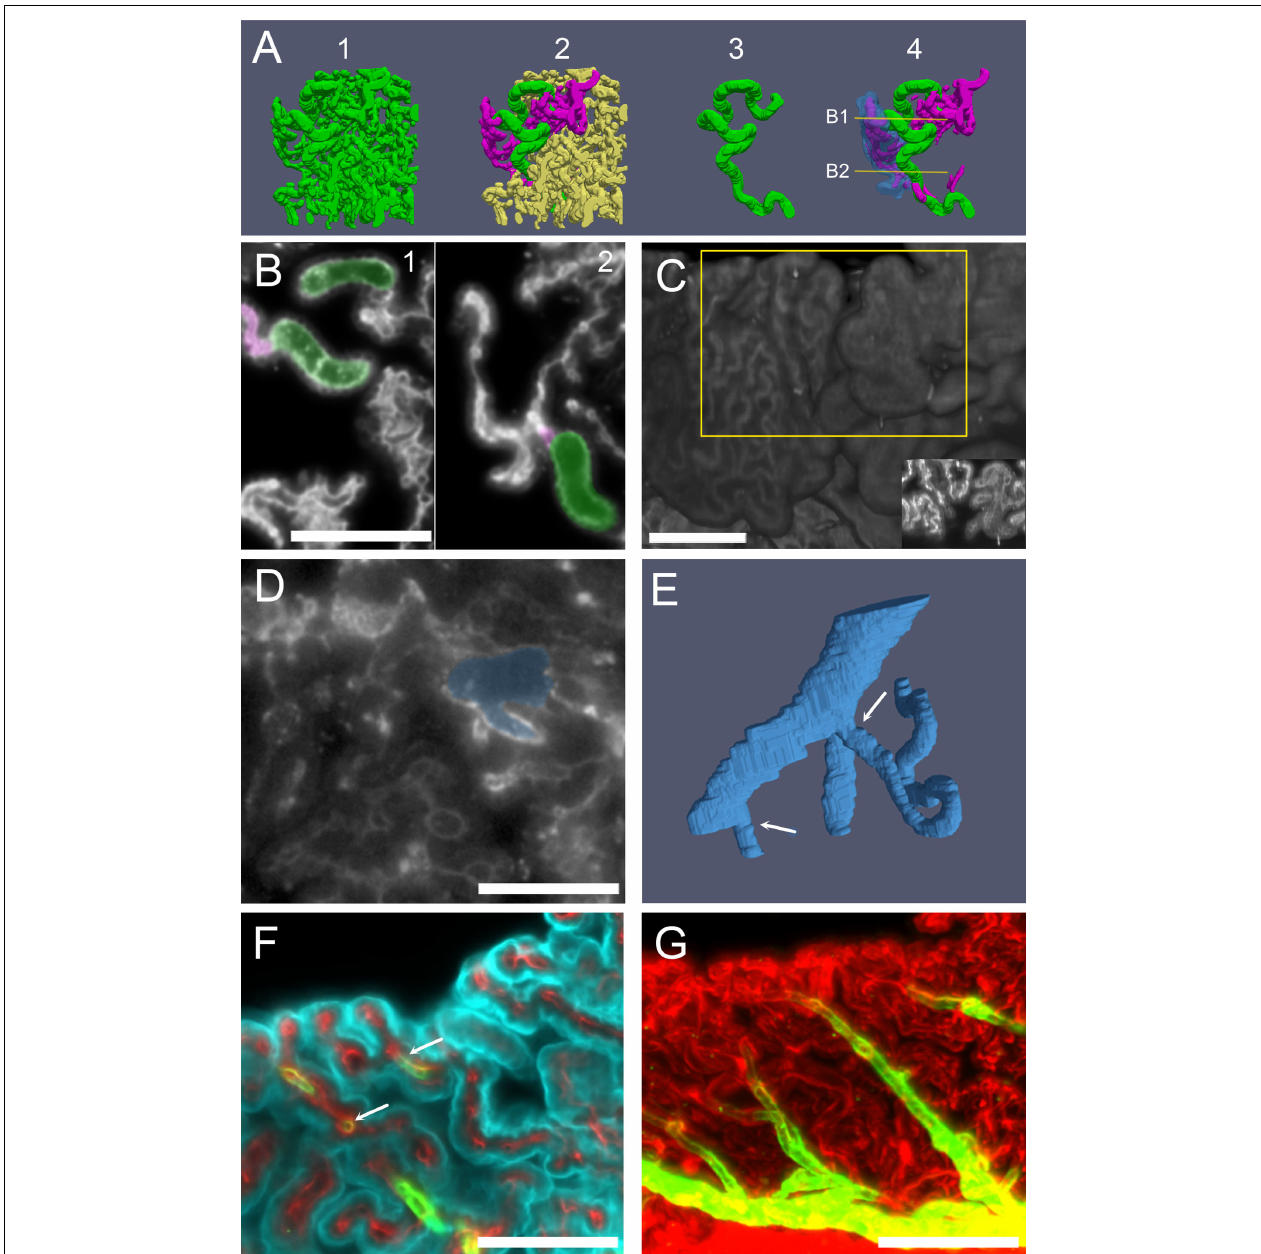
FIGURE 8 | Capillaries. (A) Three-dimensional reconstruction of capillaries from a male rat CSS labeled with anti-IgG. Capillaries have been segmented from a cube of CSS CP. 1: All vessels shown together, displaying the full vascular density of the segmented volume. 2: A single large capillary (green) and the small capillaries connected to it (magenta) are evidenced. 3: The large capillary shown in isolation. No branches are present in most large capillaries, which follow a very tortuous path. 4: The large capillary and its connected small capillaries are shown: the epithelium overlying a small capillary anastomotic network (SCAN) is shown in blue (semitransparent). SCANs branch within single villi, which may be folded, making the network appear more complex. Lines and arrows mark the planes and attachment points shown in (B) . (B) Single optical sections (labeled with anti-IgG) of the stack used for the reconstruction in (A) , showing that the SCAN (highlighted magenta) is attached to the same large capillary (highlighted green) at several levels (arrows). Scale bar: 100 µ m. (C) Three-dimensional reconstruction of the ventral surface of CP CSS labeled with IgG. Villi from two adjacent fronds display only small (left) or only large capillaries (right) on the surface. Scale bar: 200 µ m. Inset: Z-stack maximal projection from 10 optical sections from the region highlighted by the yellow box. (D) Single optical section (labeled with anti-IgG) showing the junction between a large tortuous capillary and a vein. Scale bar: 100 µ m. (E) Three-dimensional reconstruction of the capillary-venous junction. Arrows point at the two capillaries entering the vein branches. One of the capillaries is cut short for clarity. (F) COLM image of a CP frond showing the arteriole junctions: a straight arteriole (labeled with SMA, green) contacts capillaries (labeled with Col-IV) with the same initial diameter (arrow). Cyan, Notch-2. Since ColIV also labels CP epithelial basal lamina, connections are seen between vessels. (G) Z-stack maximal projection of the same sample as (F) , showing the whole course of the arteriole (30 µ m z-range; 3 µ m steps, 10 planes). Red, ColIV; green, SMA. Scale bar: 100 µ m.